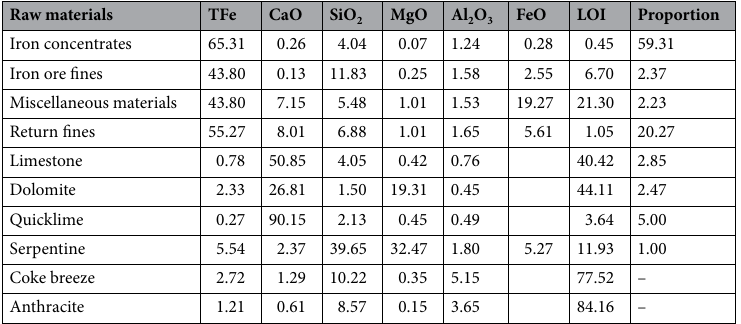
Table 1. Chemical compositions of all of the raw materials in the sinter mixture (mass %). LOI loss on ignition.